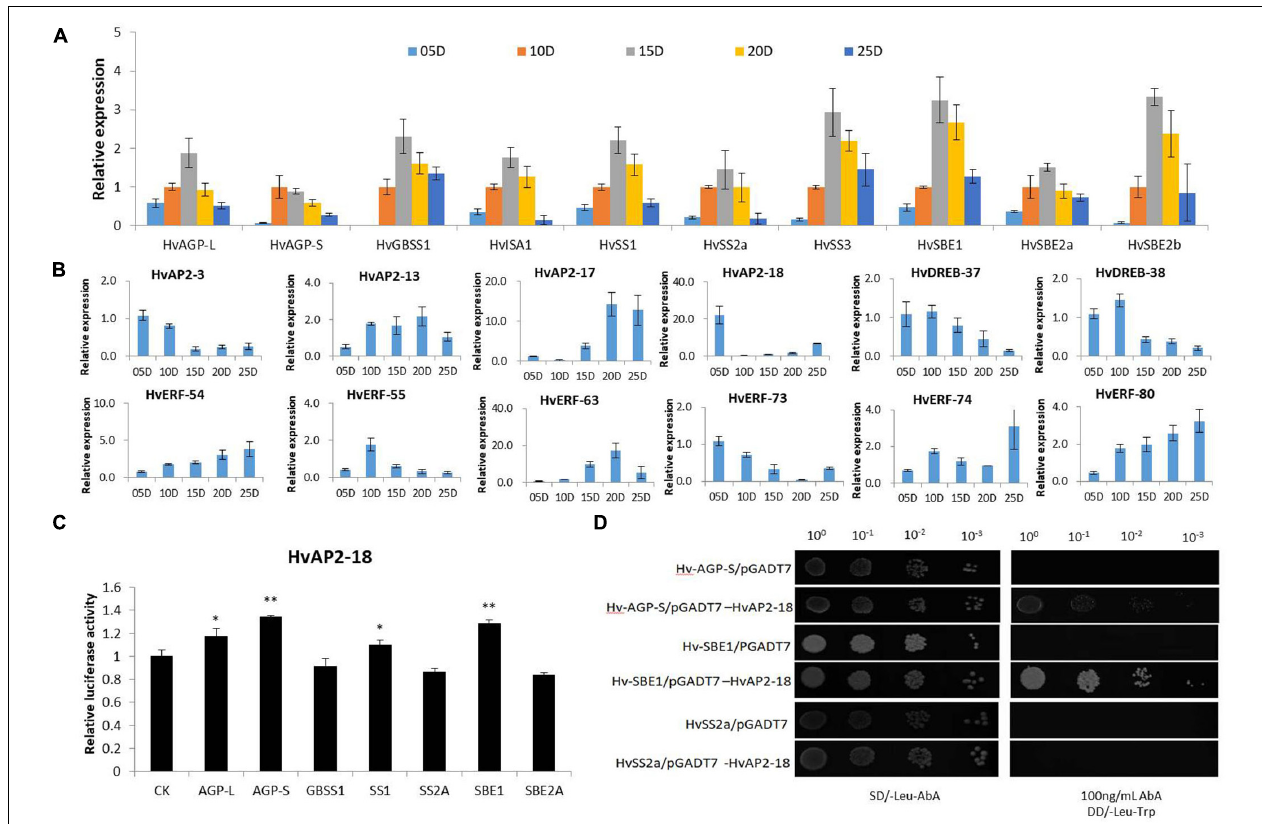
FIGURE 6 | Co-expression and interaction analyses of HvAP2/ERF candidate genes involved in starch synthesis. (A) Relative expression levels of key starch synthase genes. DPA: days post anthesis. (B) Relative expression levels of 12 HvAP2/ERF genes. (C) Characterization of the interaction between the HvAP2-18 protein and the promoter of starch synthase genes via LUC assay. (D) Characterization of the interaction between the HvAP2-18 protein and the promoter of HvAGP-S , HvSBE1, and HvSS2a via yeast one-hybrid assay. Statistically significant differences are indicated: *, P < 0.05; **, P < 0.01 (Student’s t